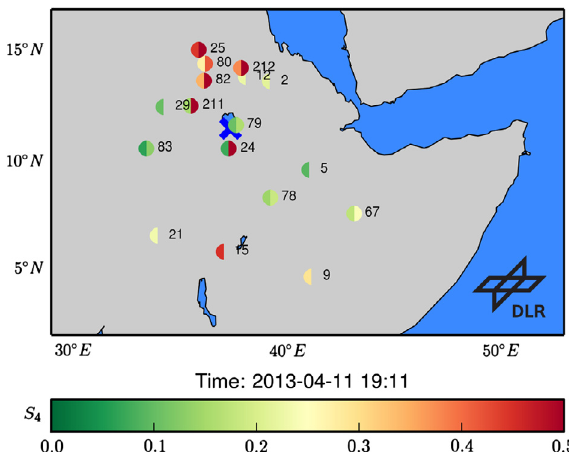
Figure 1. Constellation of ionospheric pierce points at Bahir Dar Ethiopia. The blue cross marks the location of the receiver. The color of the pierce points corresponds to the strength of the amplitude scintillation S 4 as indicated by the color bar below. The left half circle shows L1 (C/A)/E1. The right half circle shows GPS L5, GLONASS L2 and Galileo E5a, if available. The number next to the pierce point corresponds to the satellite id according to NMEA